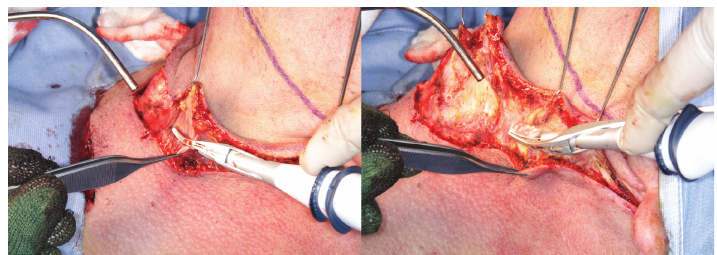
Figure 2: Section of platysma muscle with Focus Ultracision harmonic scalpel during dissection of upper cervical flap.